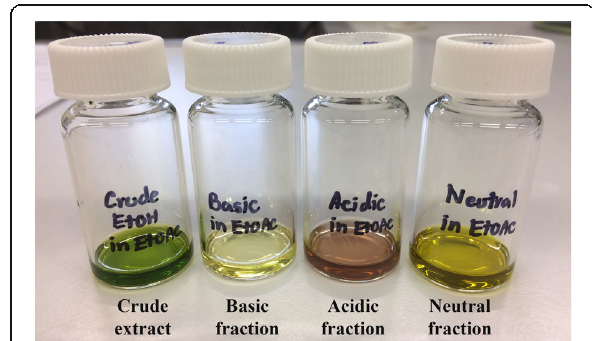
Fig. 2 Crude ethanolic extract of S. asper leaves and its acid-base